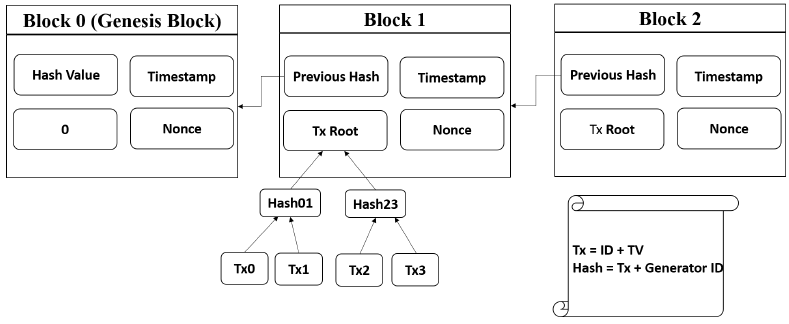
Figure 9. Sample Configuration of a Block.